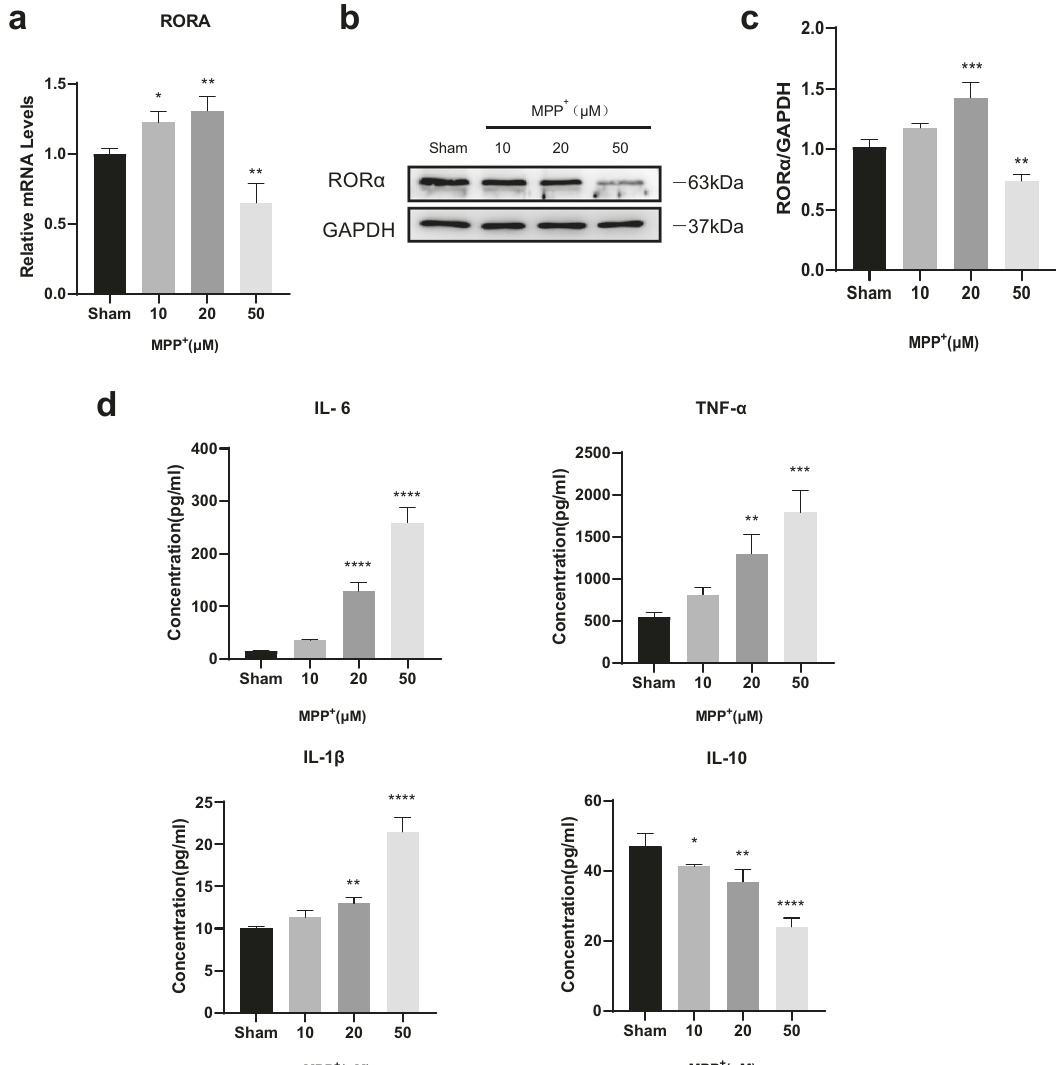
Fig. 1 The level of ROR α was reduced in BV2s treated with MPP + . BV2 cells were treated in different concentrations (0, 10, 20, 50 μ M) of MPP + for 24 h. a Relative mRNA levels of ROR α were measured by RT-qPCR. b , c Immunoblot analysis of ROR α . Protein expression levels